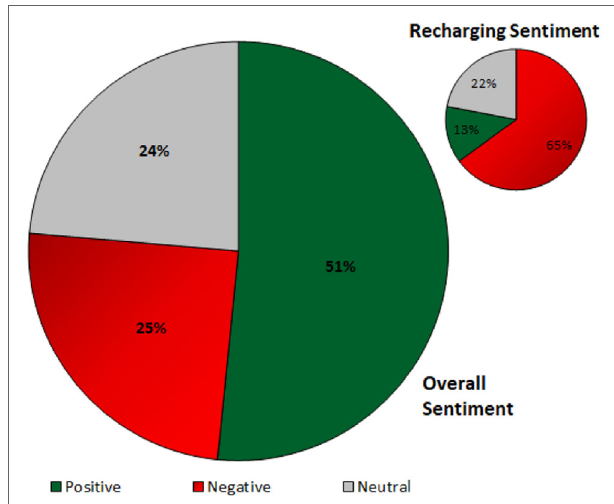
FigUre 5 | Overall sentiment, top right: recharge